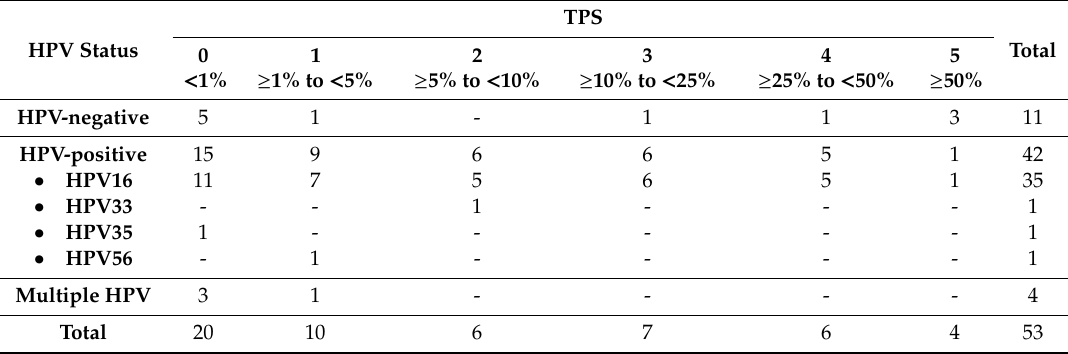
Table 3. Distribution of HPV subtypes and corresponding PD-L1 expression